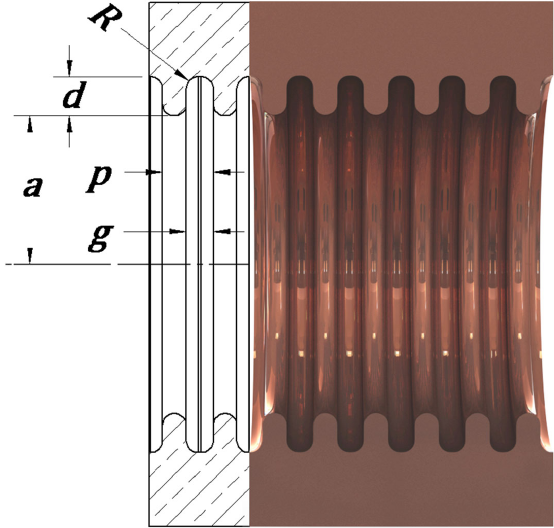
FIG. 1. Dimensions of the cylindrical corrugated waveguide: a ¼ 1 mm, p (period) ¼ 340 μ m, g (gap) ¼ 180 μ m, d (depth) ¼ 264 μ m, R (corner radius) ¼ 80 μ m.